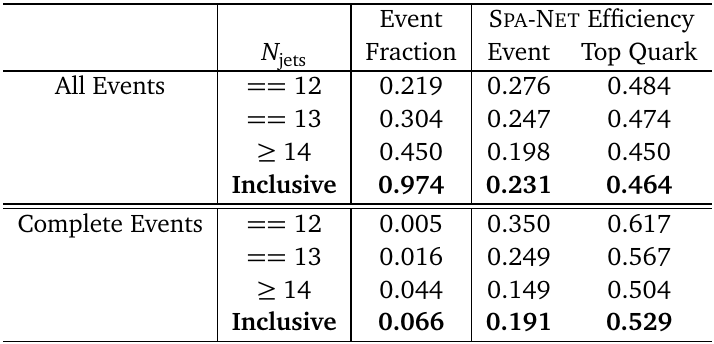
Table 3: Performance of S PA -N ET for t ¯ tt ¯ t reconstruction in events with ≥ 4 b -tagged jets. No comparison is shown with the χ 2 method, which is intractable in this dataset.